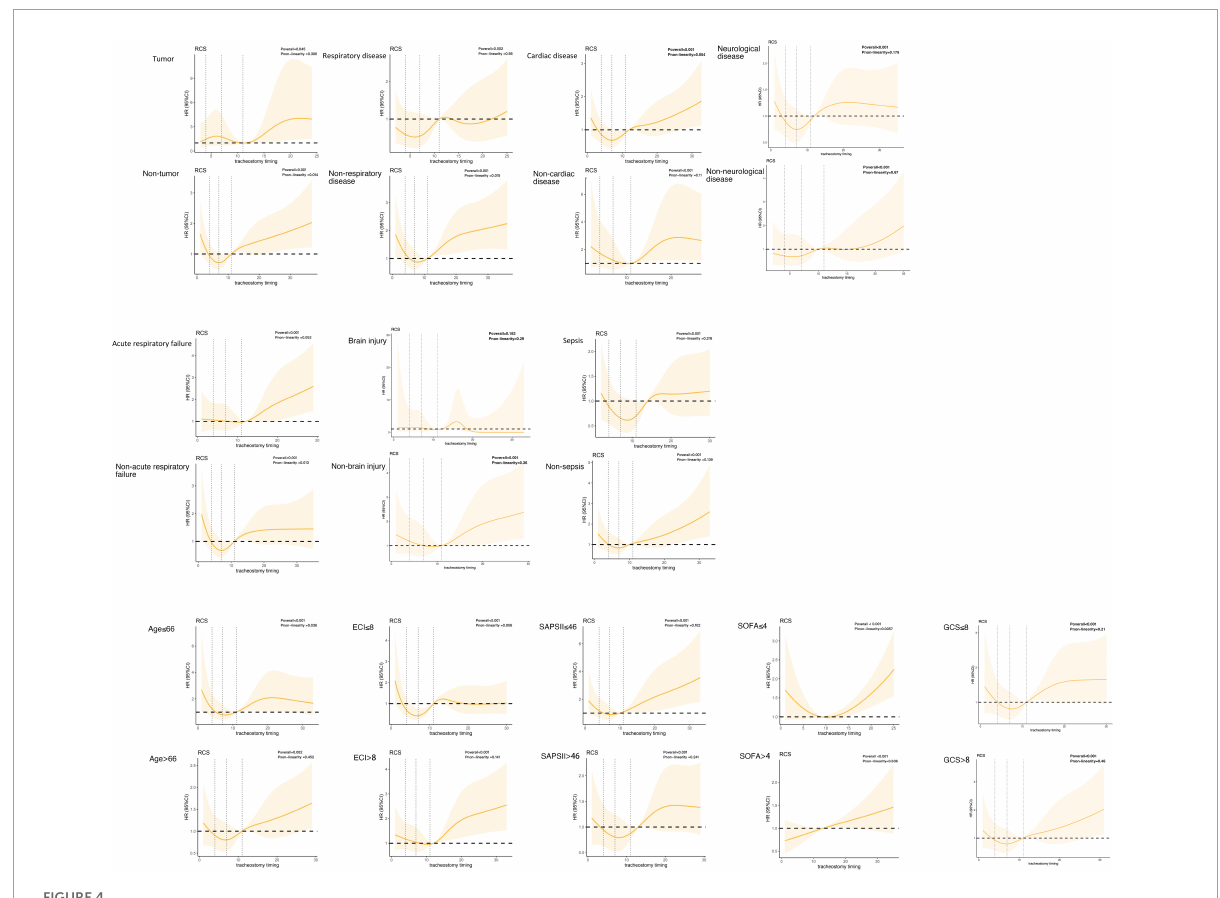
FIGURE4 Association with tracheostomy timing and mortality in different patient groups.